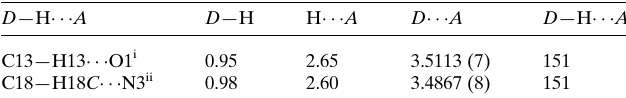
Table 2 Hydrogen-bond geometry (A˚ , (cid:2) ).